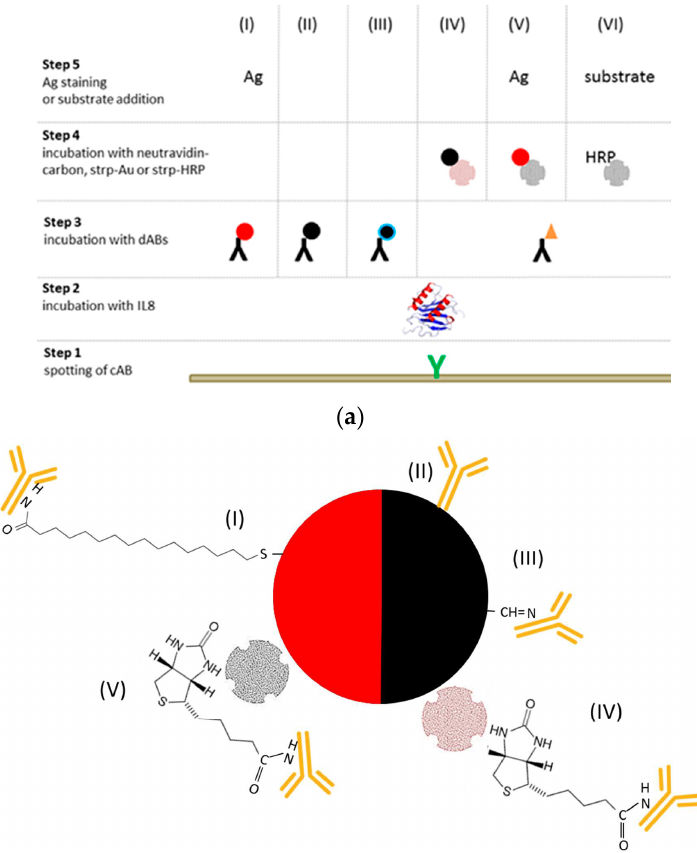
Figure 1. ( a ) Schematic presentation of six distinct assay formats for colorimetric detection: (I) cAB + IL8 + gold-labeled dAB, (II) cAB + IL8 + carbon-labeled dAB, (III) cAB + IL8 + oxidized carbon-labeled dAB, (IV) cAB + IL8 + biot. dAB + neutravidin–carbon, (V) cAB + IL8 + biot. dAB + strp–gold, and (VI) cAB + IL8 + biot. dAB + strp-HRP + enzyme substrate. Slides treated via gold nanoparticles were further stained by silver (Ag). ( b ) Illustration of the antibody (in orange) coupling process using gold (red) and carbon (black)